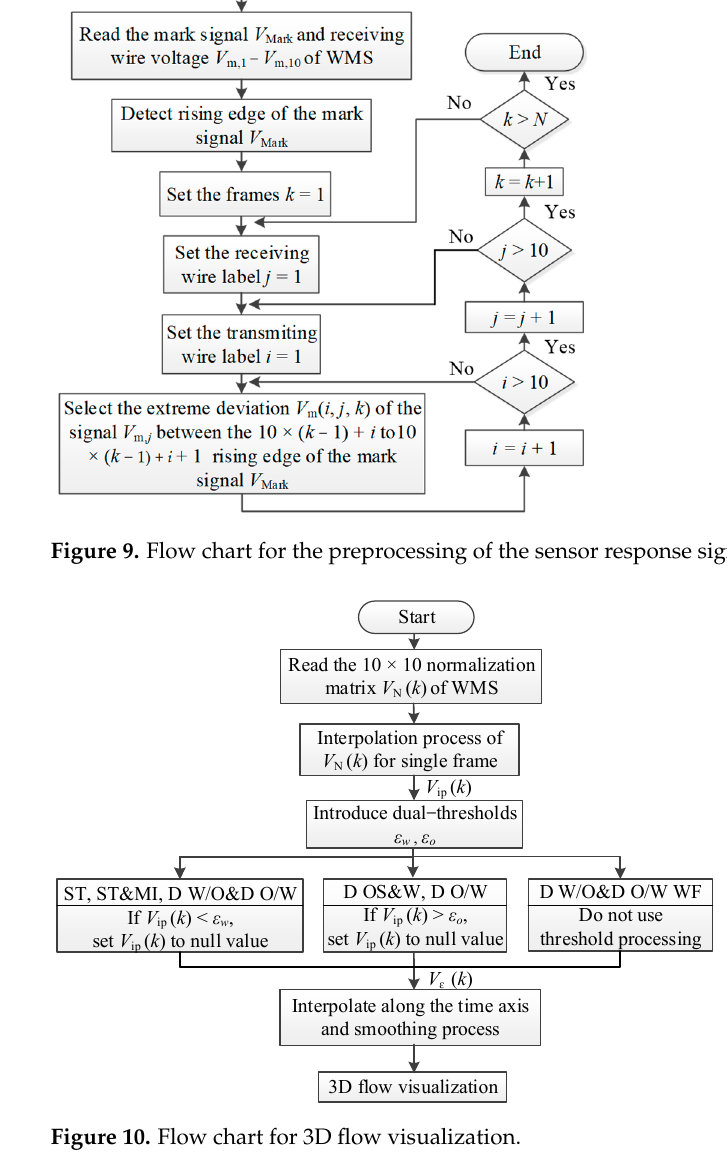
Figure 10. Flow chart for 3D flow visualization.